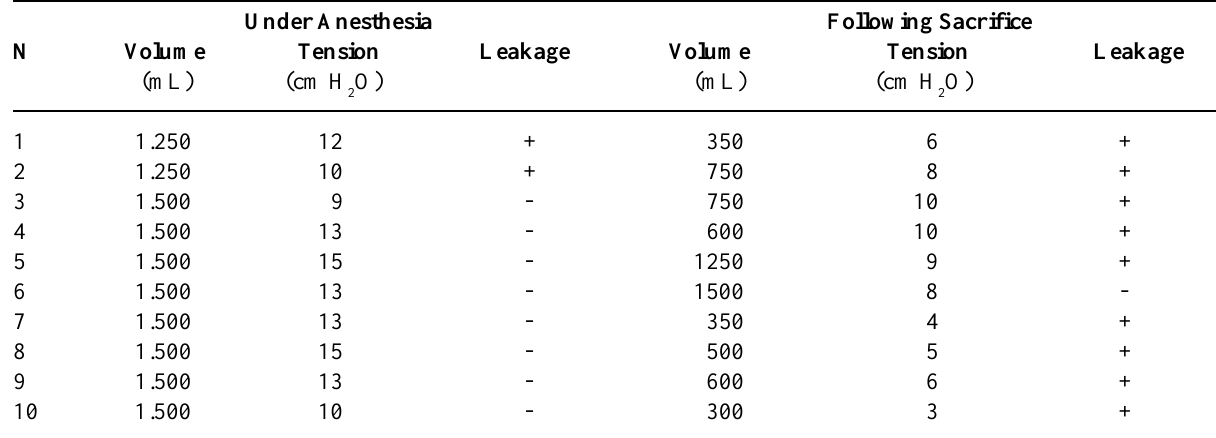
Table 3 – Continence test in the control group. Mean volume of saline solution infused under anesthesia (1450 mL